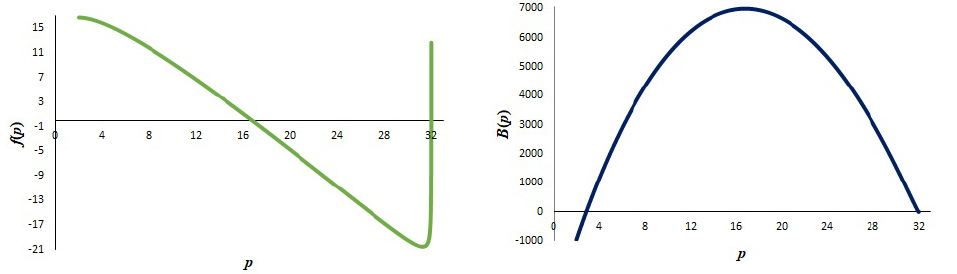
Figure 6. Functions f ( p ) and B ( p ) for Example